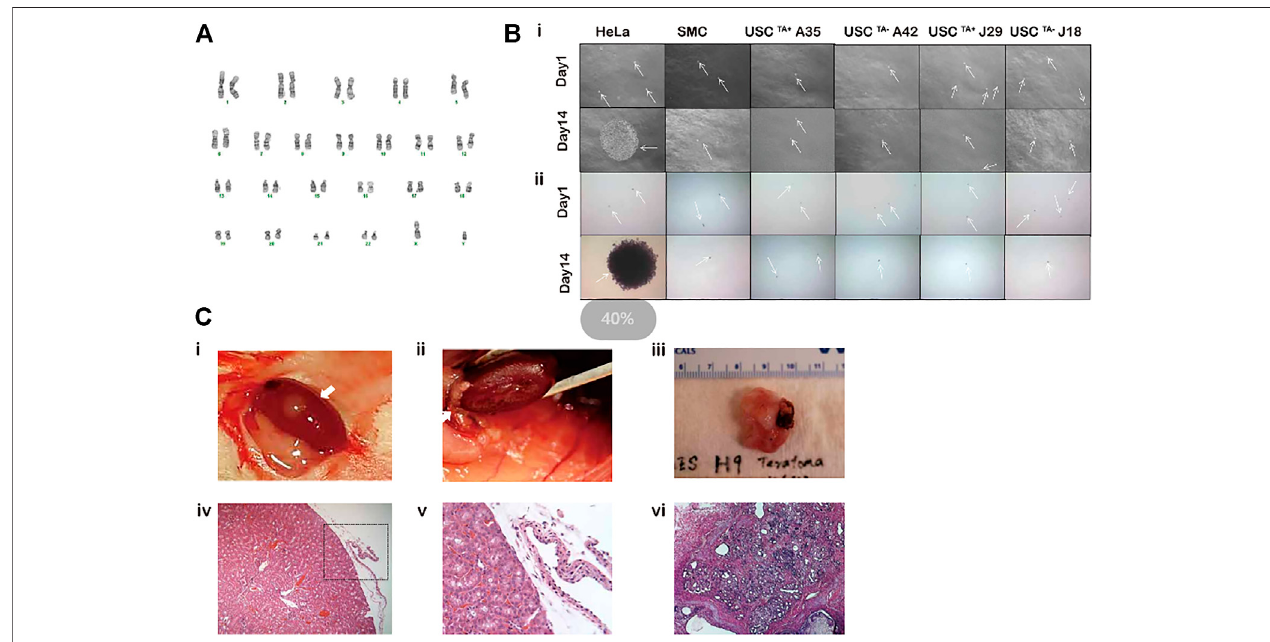
FIGURE 8 | Spontaneous transformation assays of USC TA+ clones. (A) Karyotypes of USC TA+ vs. USC TA − clones. Both USC TA+ ( n = 2, A35, RTA:45.6; and J29, RTA:46.6)andUSC TA − ( n =2,A42andJ18)clonesintheearlypassage(p4)andlatepassage(TA+cloneinp12,TA-cloneatp8)displayednormalcomplementofdiploid (2n=46). (B) Invitro agarassayofUSCs.Thesizeofthecellclones(seededatadensityof5,000cells/well)ofUSC TA+ clones(A35andJ29)andUSC TA − clones(A42and J18) remained the same between days 1 and 14 after plating on soft agar gel. However, clone size of the cancer cell line HeLa cells, as the positive control, at 14 days were signi fi cantly increased compared to that at the fi rst day. Normal bladder smooth muscle cell clones were used as the negative control. Images were captured using a phase contrast microscope. Cell clones were stained with nitro blue tetrazolium and photographed using bright fi eld soft agar assays for anchorage- independent cell growth of USC TA+ in vitro . (C) In vitro transformation assay of USCs. No teratoma formation was observed under the microscope 2 months after USC TA+ (two million cells/graft, n = 2, white arrow) were implanted into the capsules of the kidneys of NSG mice. There was no teratoma observable grossly (i, ii) or microscopically (iii, iv). In contrast, H9 cells as the positive control formed derivatives of all the three embryonic germ layers (v, vi). A35-clone (USCs TA+ , RTA: 45.60) and